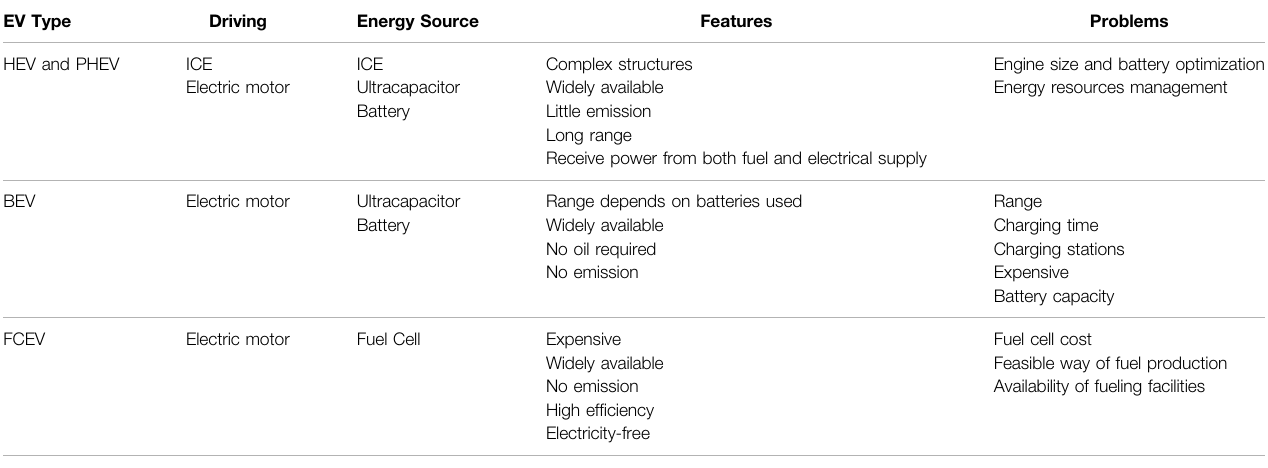
TABLE 1 | Comparison of different electric vehicle types (Chan, 2014).